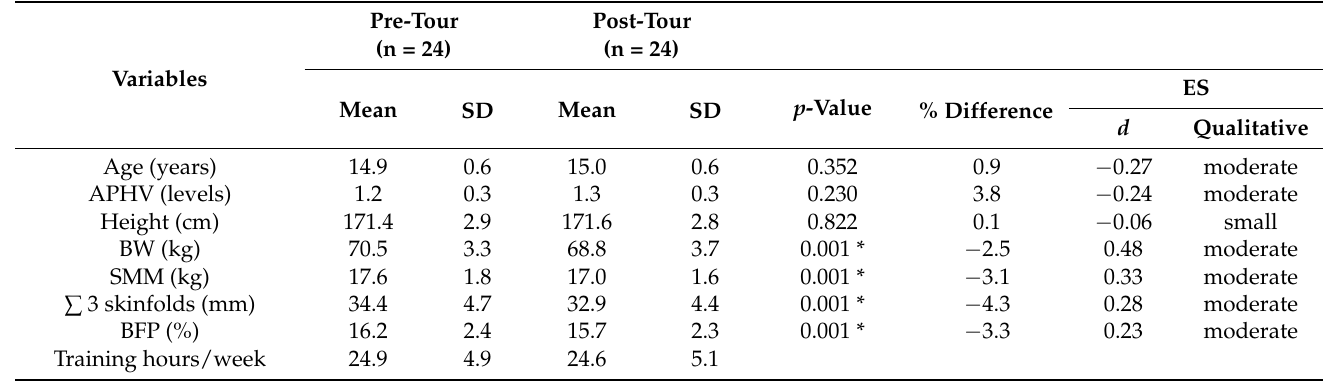
Table 1. Pre- and post-tour body composition and anthropometric